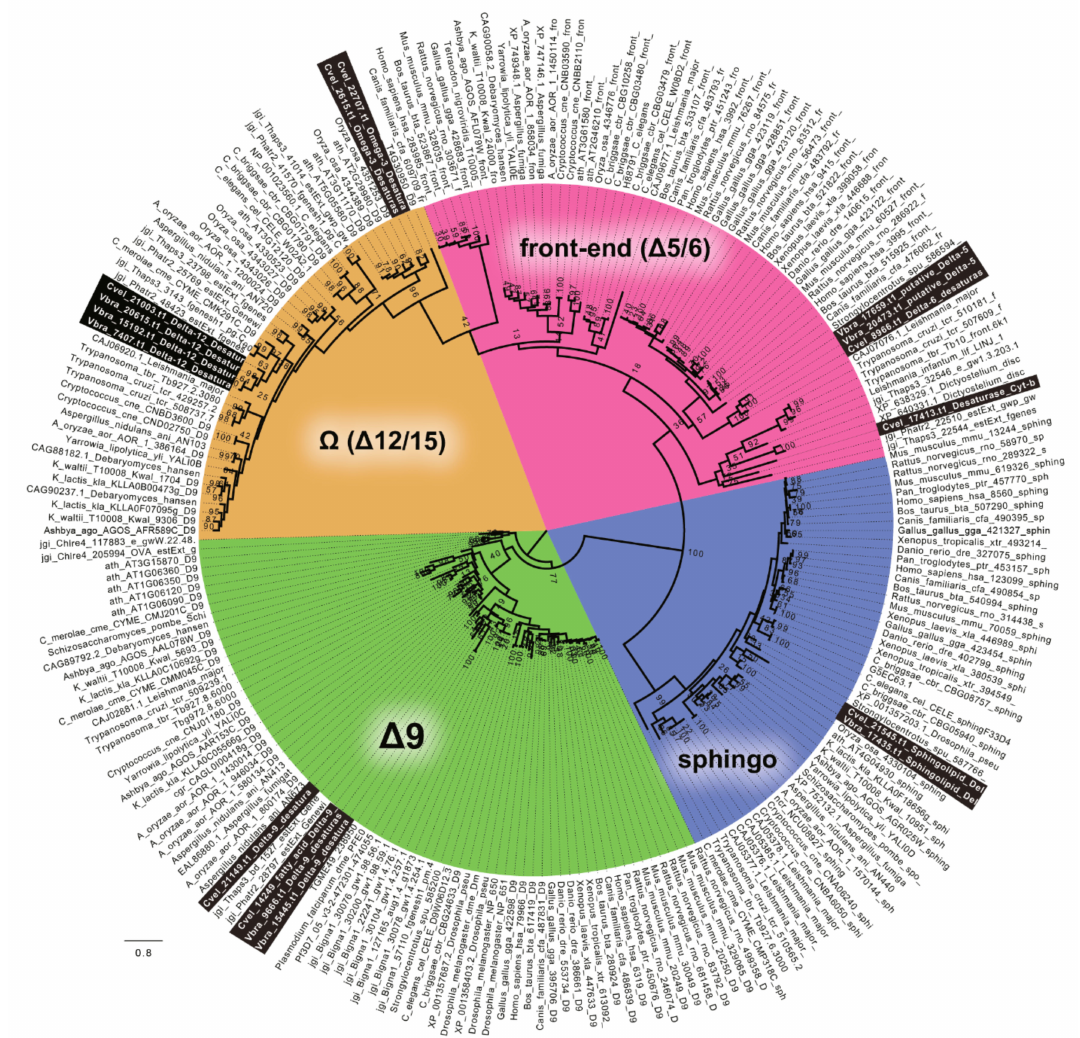
Figure 7. The RaxML tree resolving major functional classes of FA desaturases within various genomes, as described by Gostincar 2010 [50]. The chromerid genomes contain all types of desaturases. Detailed phylogenies of particular classes are displayed